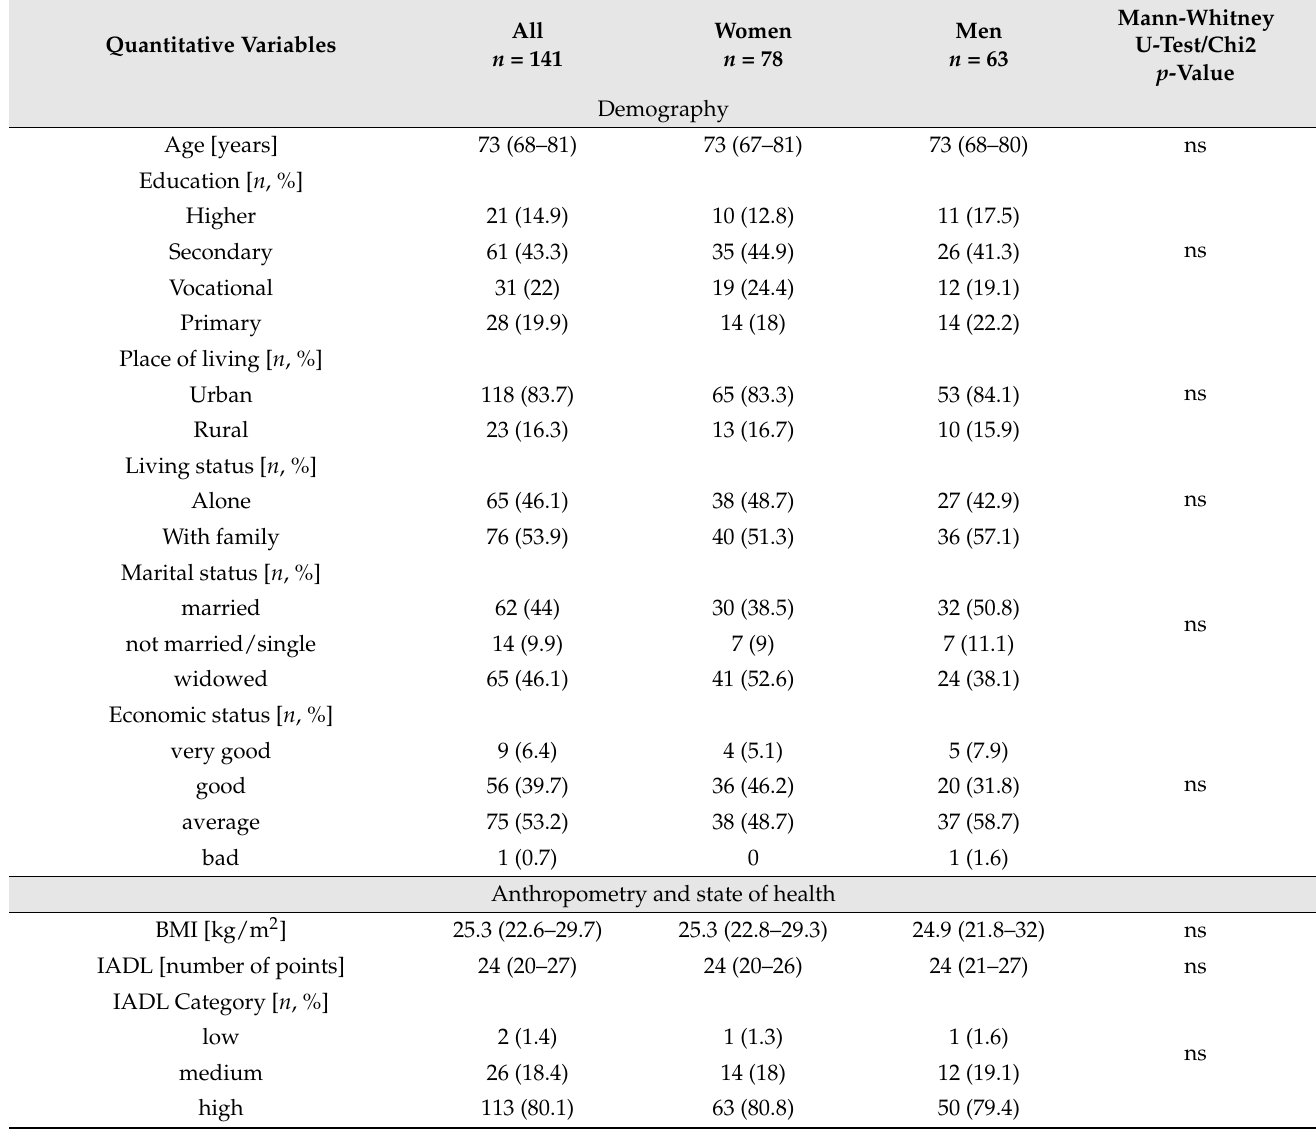
Table 1. General characteristics of the study population ( n = 141) according to